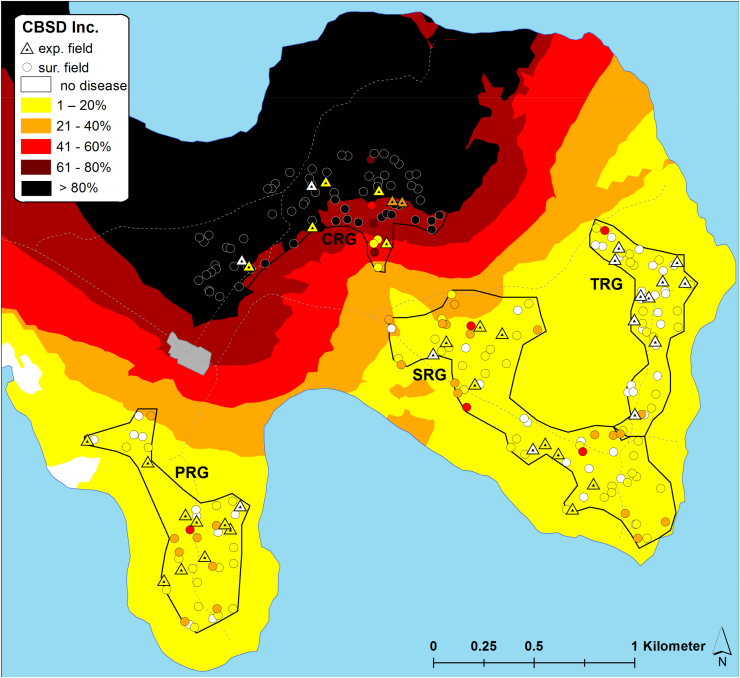
CBSD incidence in experimental (monitored) and surrounding fields in the PRG, SRG, TRG and CRG areas of Chato, north-western Tanzania. CBSD incidence data from all fields were used to develop an interpolated spatial plot of CBSD incidence using Kriging techniques.